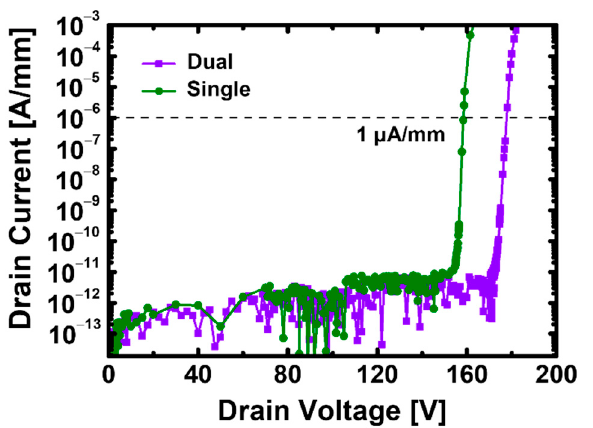
Figure 8. Breakdown voltage characteristics for recessed-gate GaN MOSFET based on AlGaN/GaN heterostructure with the stacked TiO 2 /Si 3 N 4 dual-layer insulator and Si 3 N 4 single-layer insulator at V GS = 0 V.